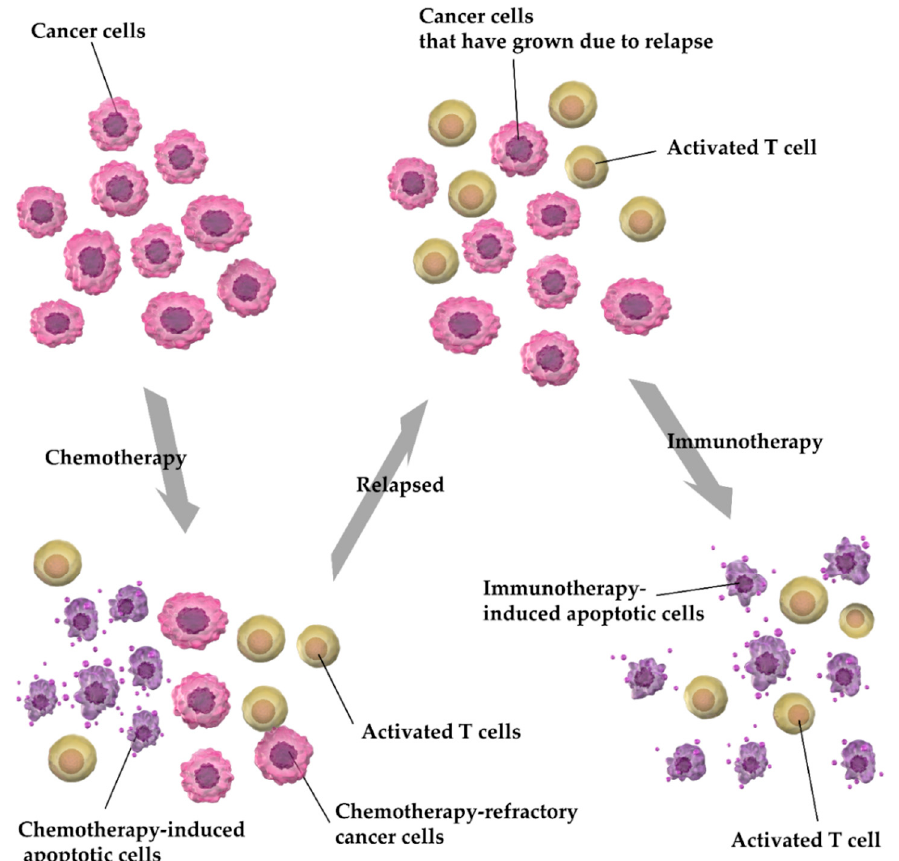
Figure 12. Mechanisms contributing to the efficacy of immunotherapy in refractory and relapsed cases. Initial treatments, such as chemotherapy, eliminate cancer cells but treatment-resistant cancer cells may survive. Treatment induces inflammation in major vicinities, leading to the formation of active T cells. The antitumor effects of these activated T cells are suppressed by cancer cells. However, immunotherapy reactivates T cells, thereby causing an anticancer effect in tissues with recurrent cancer.